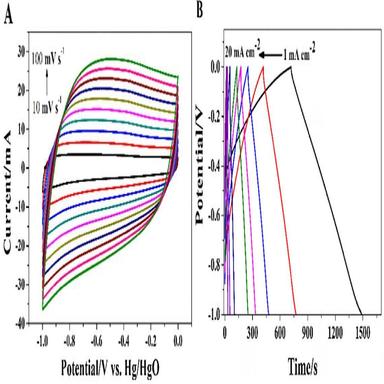
Electrochemical properties of the N-CCs/NF electrode: (A) CV curves at different scan rates of 10, 20, 30, 40, 50, 60, 70, 80, 90 and 100 mV s1 , respectively and (B) GCD profiles at the current densities of 1, 2, 3, 4, 5, 10, 15 and 20 mA cm2 , respectively.